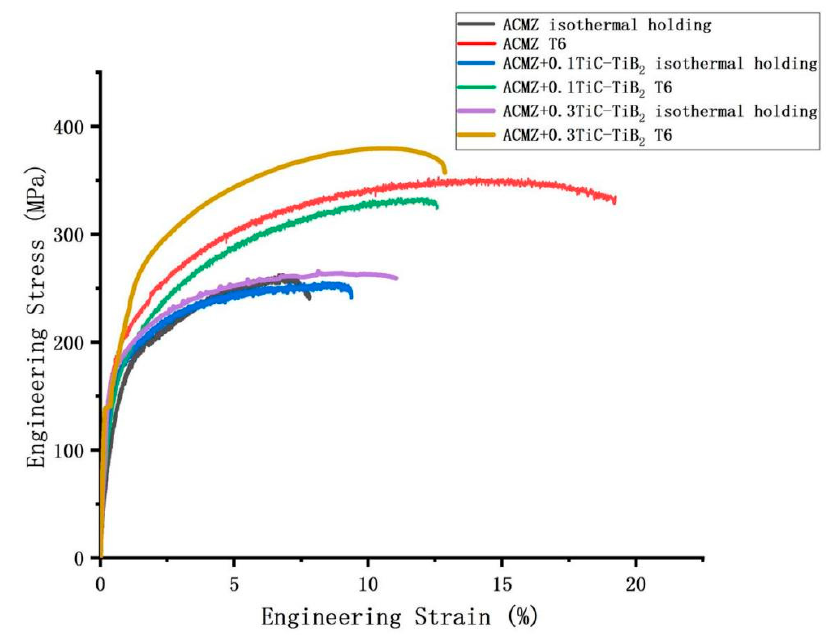
Figure 8. Stress–strain curves of alloys with different